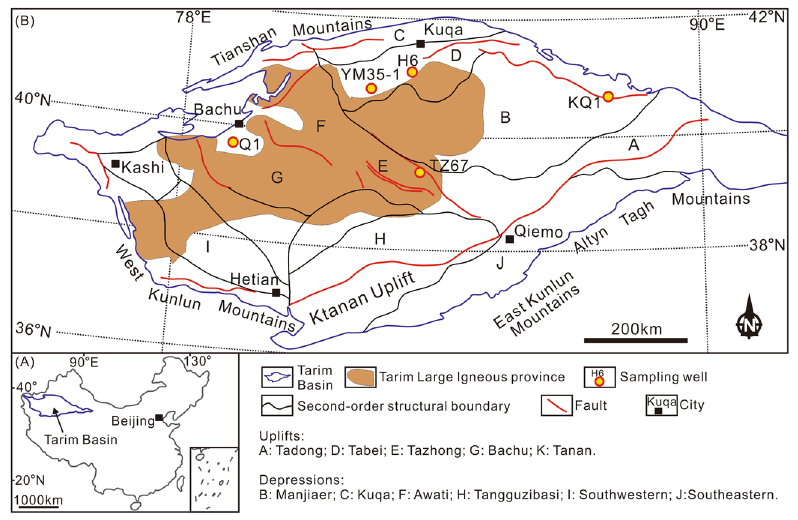
Figure 1. ( A ) Location of the Tarim Basin in China. ( B ) Map showing the locations of sampling